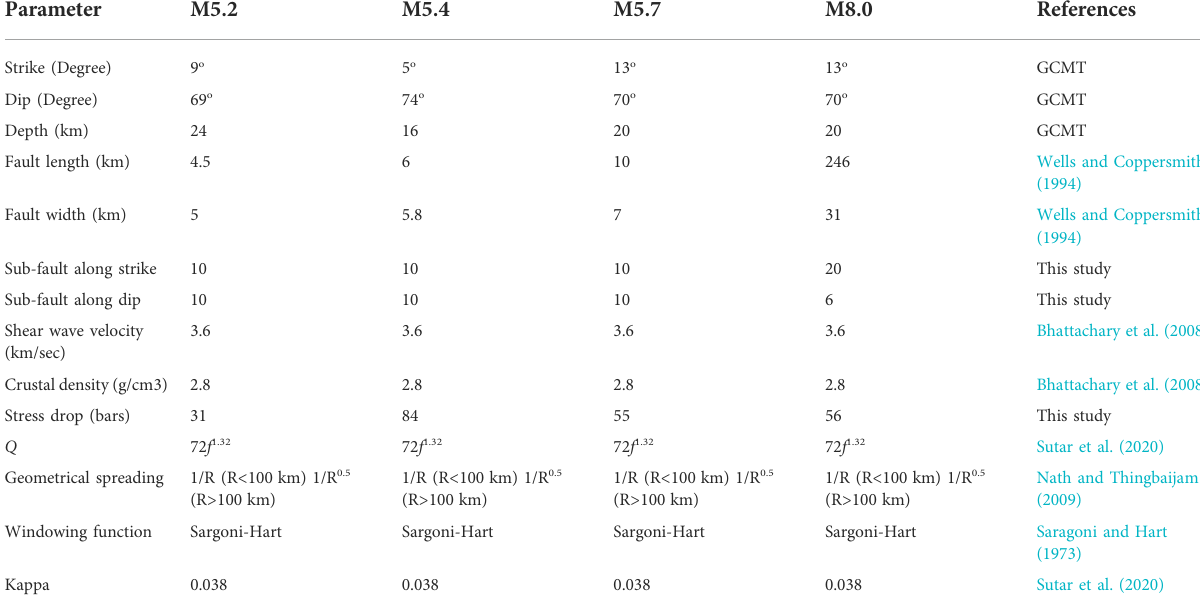
TABLE 4 The input parameters used for ground motion simulation using Stochastic Simulation technique.